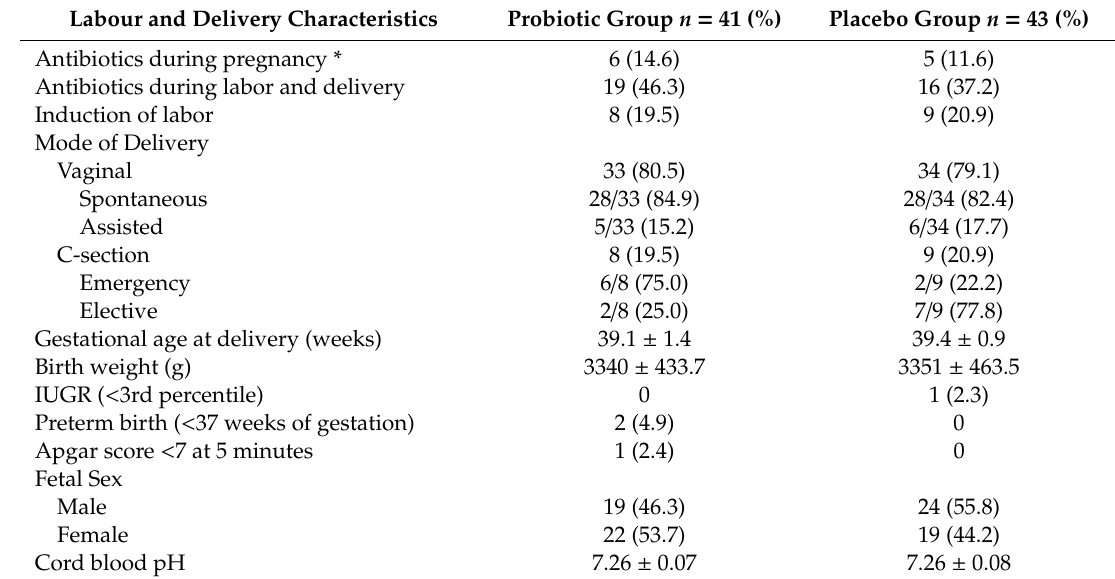
Table 2. Comparison of pregnancy outcomes between the probiotic group ( n = 41) and the